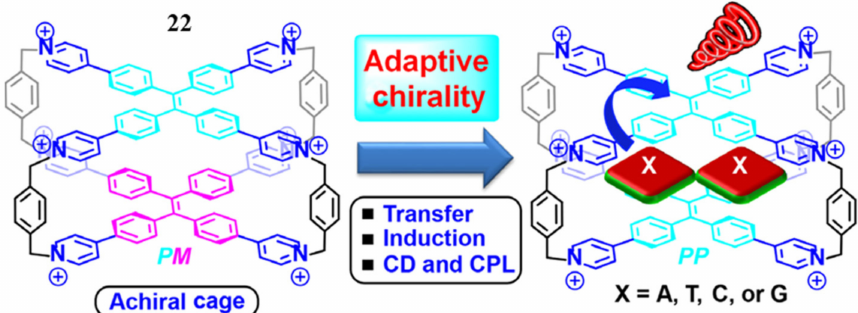
Figure 9. Mechanism of adaptive chirality of 22 produced by interaction with nucleotides. Reprinted (adapted) with permission from Ref. [36] Copyright 2020 from CCS Chemistry.